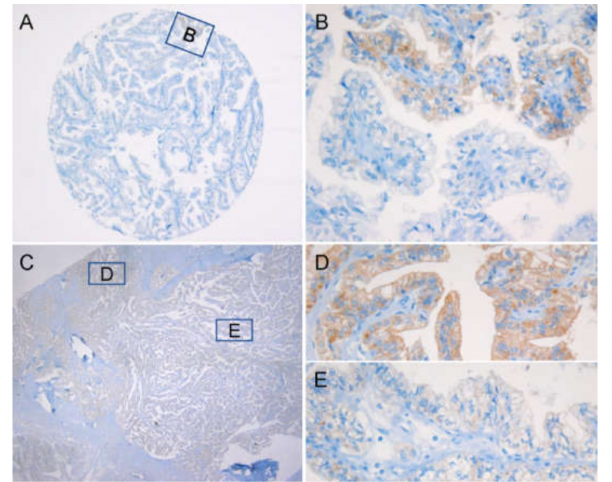
Figure 2. Heterogeneity of VE1 immunostaining. In the tissue microarray core, only a small cluster of cancer cells showed VE1 reactivity ( A ), which could be easily missed during sampling. The high-power view of the boxed area in Figure 2A shows a focal positive immunostaining ( B ). This variation from negative to strongly positive staining was further reproduced on the whole-tissue section ( C – E ); however, a proportion of VE1-positive cells was much higher; × 40 (A), × 100 (C), × 400 (B, D,